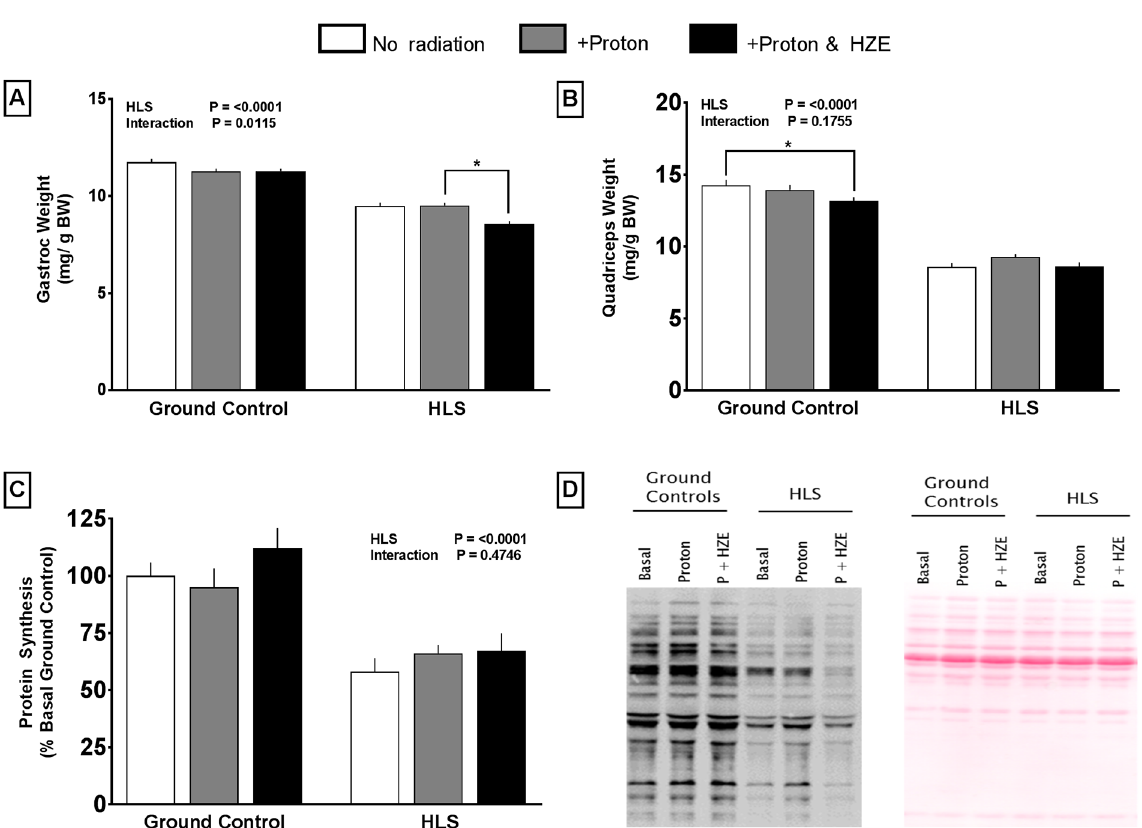
Fig 5. Effect of HLS and radiationon wet muscle weight of gastrocnemius (A), quadriceps(B), and protein synthesis (C) measured with the SUnSET method. Representative Western blot of Puromycin incorporation into muscle protein for each of the six experimental groups(D left), and representative Ponceau stain demonstrating equal protein loadingper lane (D right). Measuresare absolutevalues normalizedto body weight at conclusionof study (GC in protein synthesis). Values are means ± SEM; n = 14-18/ group (p <